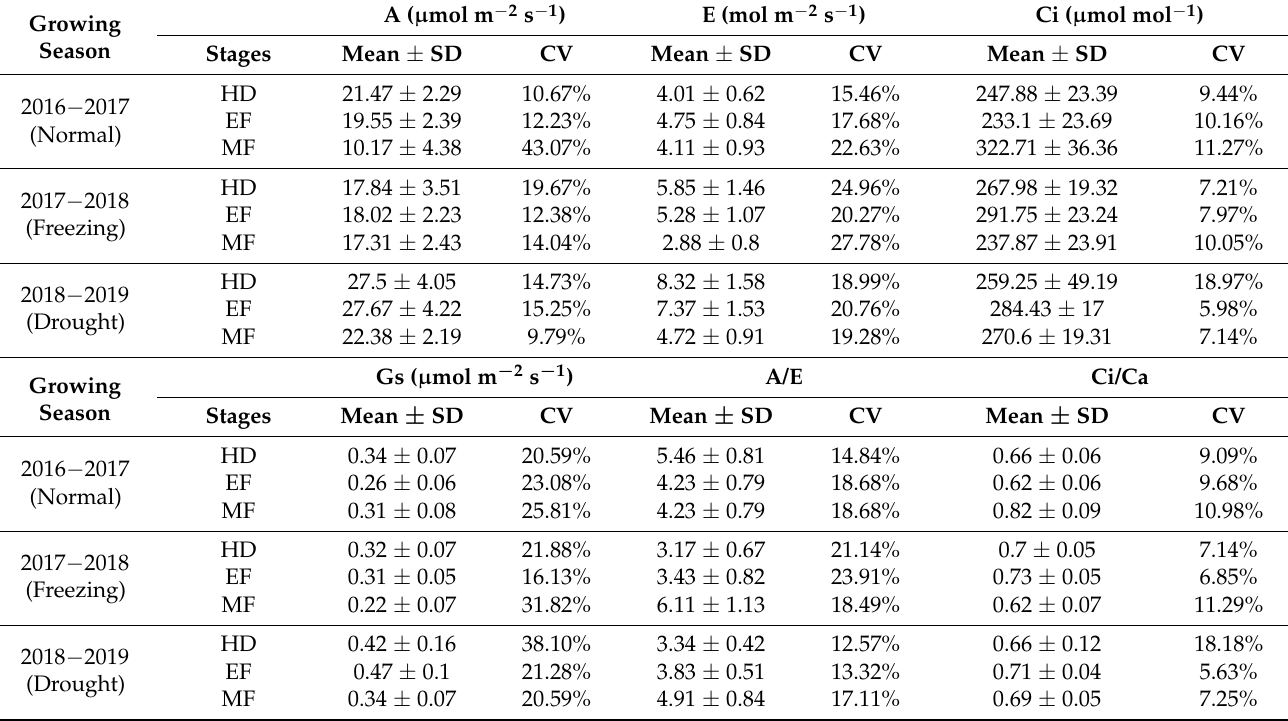
Table 2. Photosynthetic parameters at three growth stages of the three growing